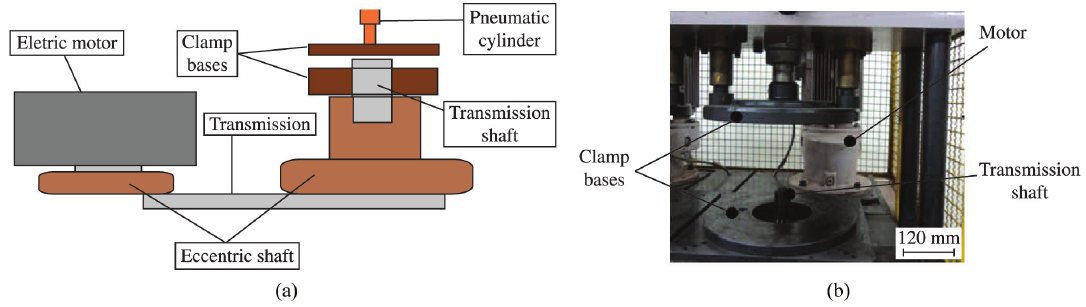
Figure 1. Diagram of the tribological system used in wear resistance testing and the determination of the coefficients of friction and wear (a) schematic view and (b) system testing.